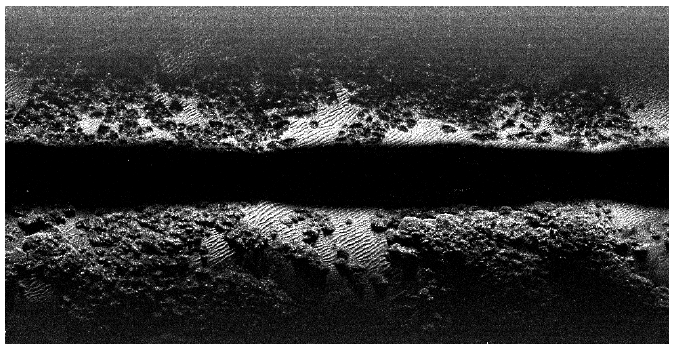
Figure 3. Example of acoustic image. Source: